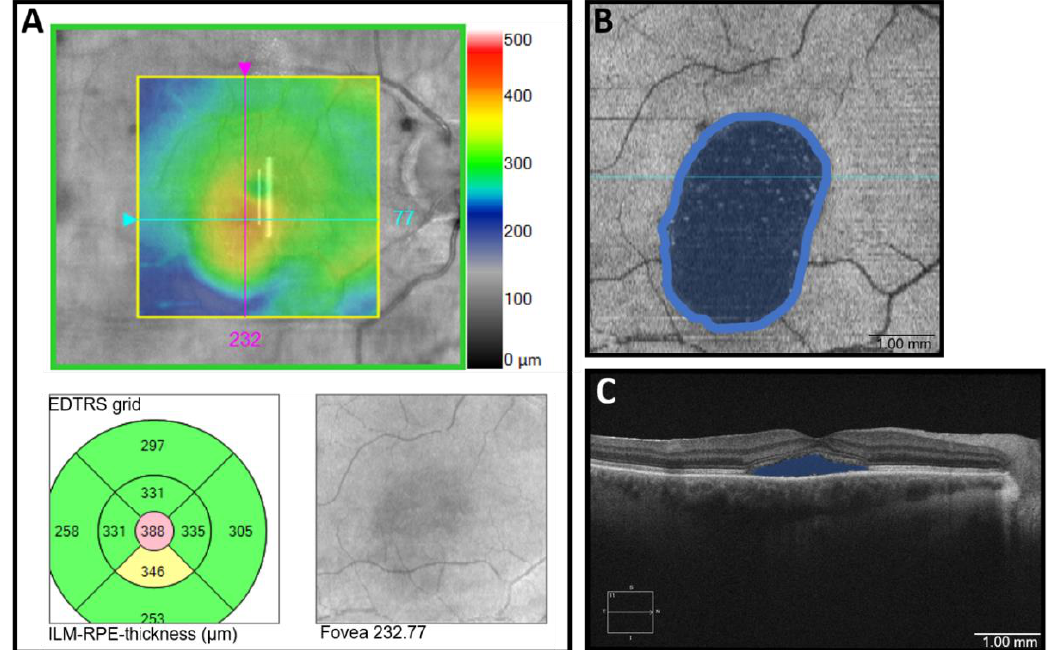
Figure 2. Visualization of methods in optical coherence tomography (OCT) and OCT- angiography in a patient with Central Serous Chorioretinopathy ( A ): Determining lesional retinal thickness = LRT: En face Analysis. The top panel shows an image of a retinal thickness map. The thickest point with the maximum extent of subretinal fluid (SRF) was determined and fixed, and the EDTRS grid was centered on this point (bottom left panel) to determine the retinal thickness (388 µm). Inner limiting membrane = ILM; Retinal pigment epithelium = RPE. ( B ): Measuring SRF area: Inner segment/outer segment ellipsoid analysis pictures of the base area of the SRF spot. The area was measured in ImageJ. ( C ): Measuring apical SRF = aSRF: OCT B-scan. The maximum extent of SRF was measured using the device’s measuring tool .